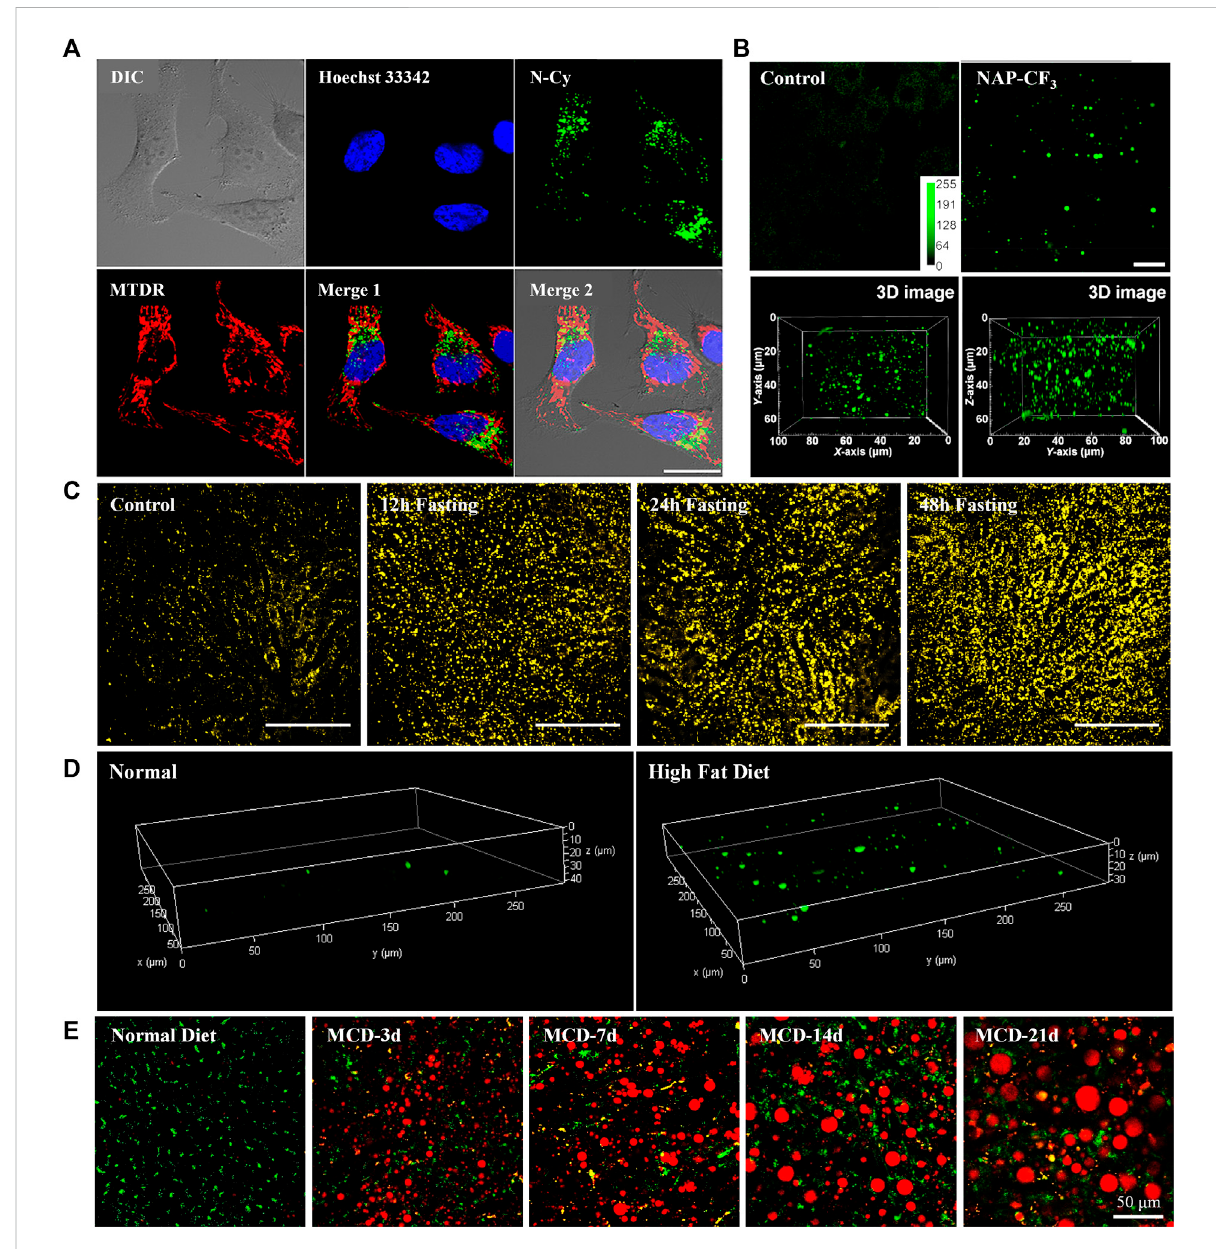
FIGURE 2 (A) Co-localizationexperimentsof 5 (Green,LDs),Hoechst33,342(Blue,nucleus),andMitoTrackerDeepRed(Red,mitochondria).Reproduced with permission from Guo etal., 2018. Copyright 2018 American Chemical Society. (B) Ex vivo two-photon images oflive mice liver tissue incubated with or without 6 , and the reconstructed 3D image. Reproduced with permission from Niu et al., 2018. Copyright 2018 American Chemical Society. (C) Representative images of hepatic LDs using 8 in the liver of anesthetized mice after normal feeding or fasting. Reproduced with permission fromMoonandKim,2021.Copyright2021TheKoreanSocietyofLipidandAtherosclerosis. (D) Reconstructed3DTPMimagesofnormalmouseliver tissue and fatty liver disease mouse tissue stained with 9 . Reproduced with permission from Han et al., 2022. Copyright 2022 Royal Society of Chemistry. (E) Mergedimages ofdual-colorTPM experiments ofLDs (Red, 10